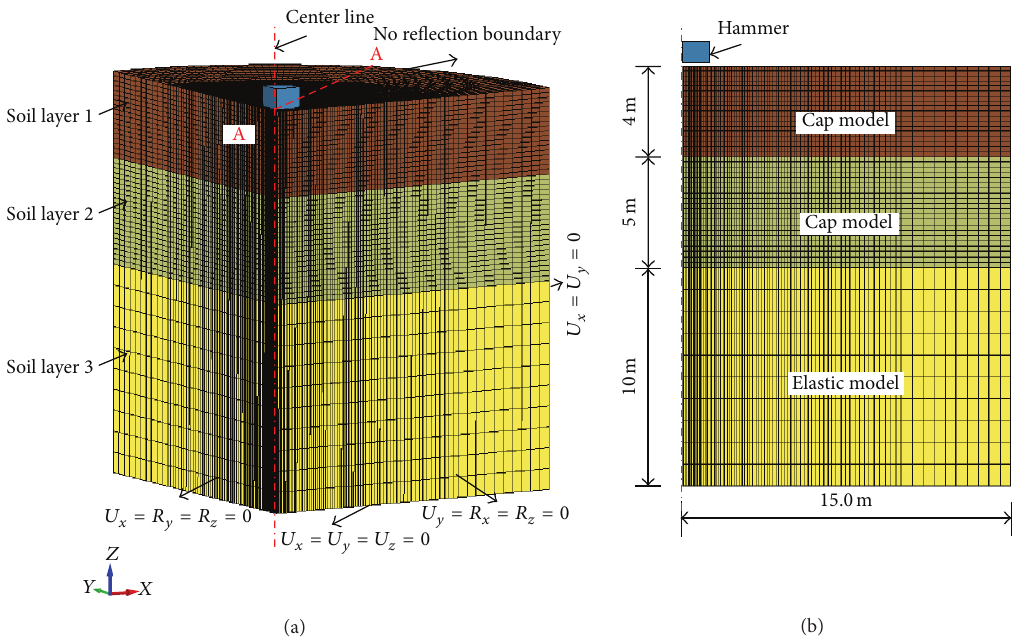
Figure 8: Schematic diagrams of (a) FEM model and boundary conditions and (b) profile of the A-A section.